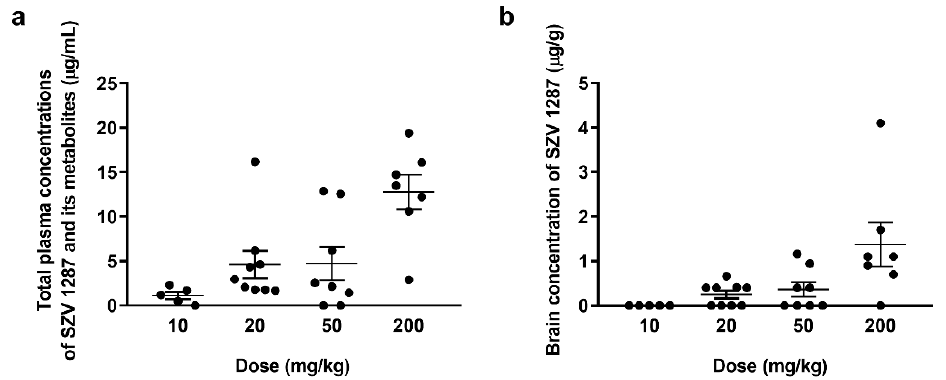
Figure 2. ( a ) Plasma concentrations of SZV 1287 and its main metabolites (oxaprozin, L 2805, L 2799, and L 2811) and ( b ) brain concentrations of SZV 1287 following single enterosolvent capsule treatment (10, 20, 50, and 200 mg/kg) in mice. Data are shown as means ± S.E.M. of n = 5–9 mice/group.